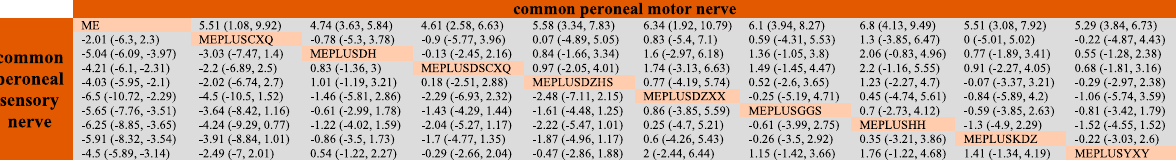
TABLE 6 Network meta-analysis of common peroneal